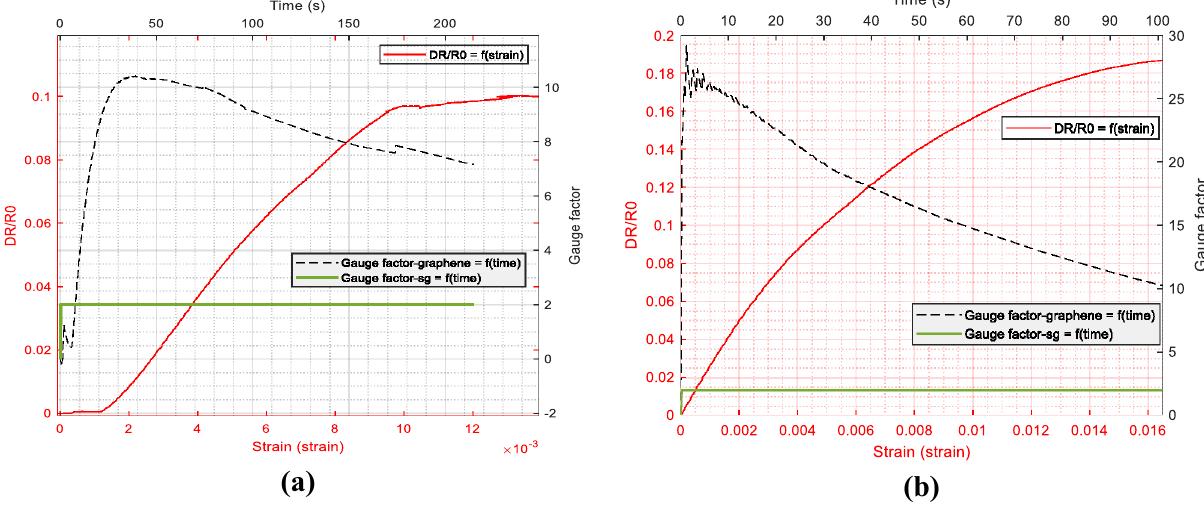
Fig. 15 Gauge factor variation the graphene-based strain sensor in the function of time calculated under normal tensile load for a CFRP sample and b GFRP